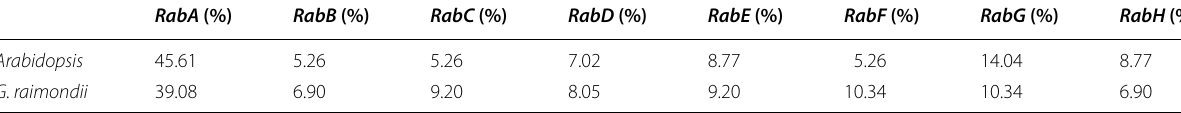
Table 3 The proportion of Rab genes in the eight groups between Arabidopsis and G. raimondii RabA (%) RabB (%) RabC (%) RabD (%) RabE (%) RabF (%) RabG (%) RabH (%)